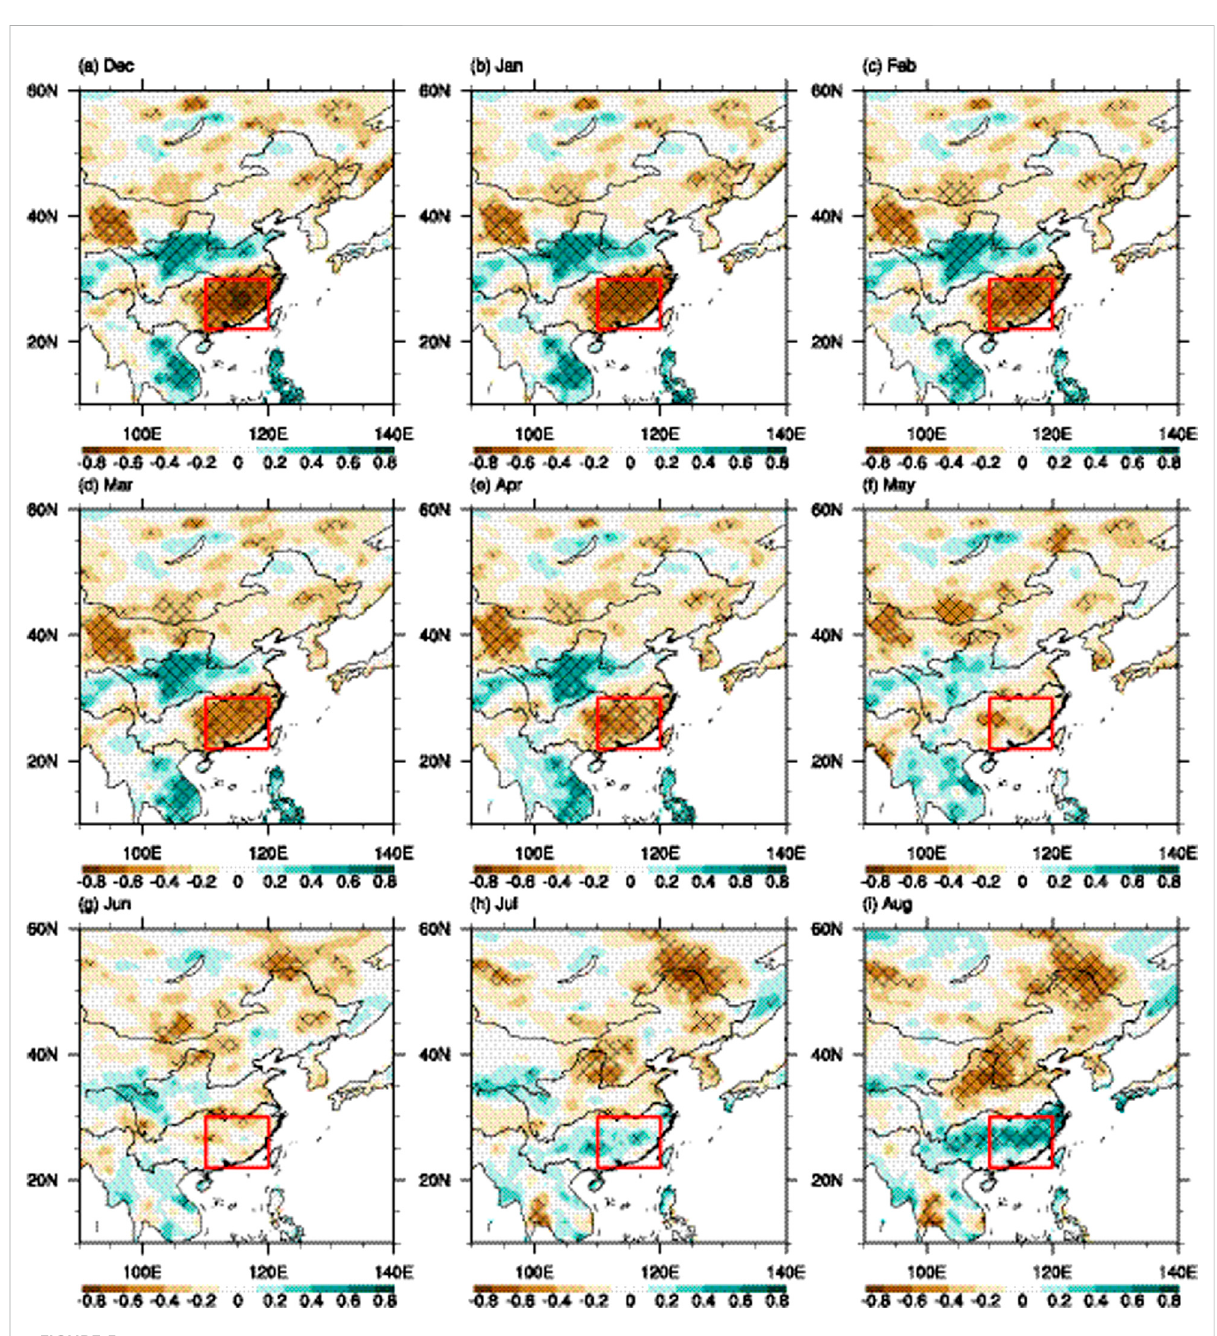
FIGURE 5 Correlation coef fi cients between PC1_obs and soil moisture in the preceding (A) December, (B) January, (C) February, (D) March, (E) April and (F) Mayandthesimultaneous (G) June, (H) Julyand (I) August.Themeshesdenotethecorrelationcoef fi cientssigni fi cantatthe95%con fi dencelevel based on Student ’ s t